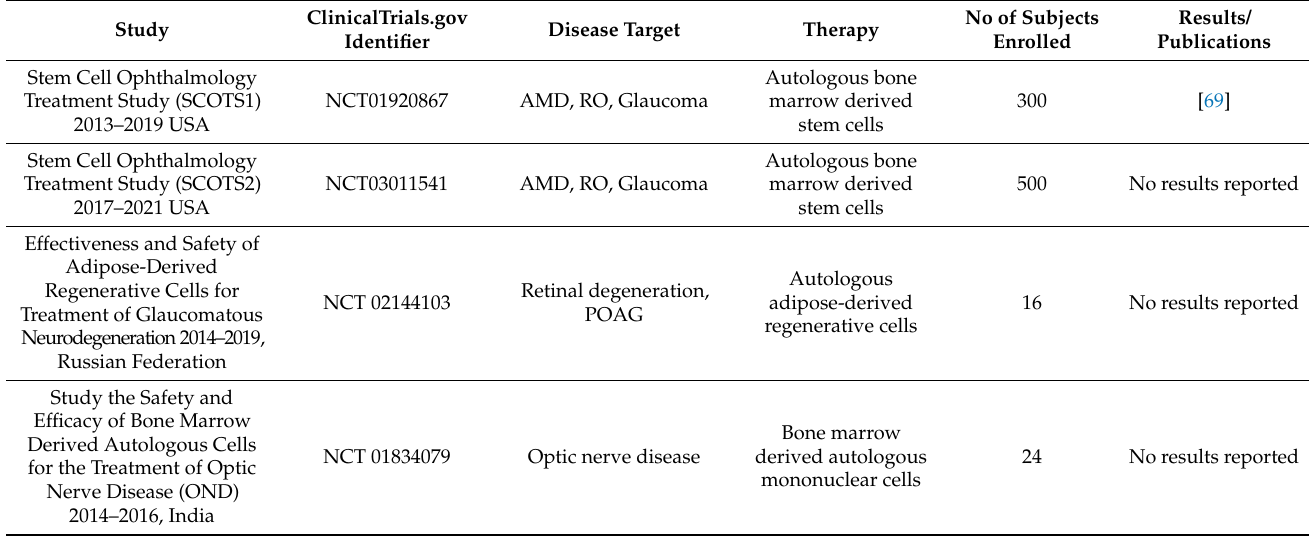
Table 1. Clinical trials investigating stem cell therapies in glaucoma and optic nerve atrophy that are registered at the National Institute of